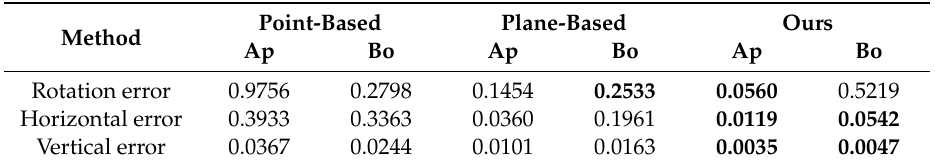
Figure 5. The coarse registration result of Boardroom. ( a ) The source and target point clouds. ( b ) The registration result of the simplified 2D point clouds. ( c ) The registration result of the 3D point clouds. ( d ) The registered point clouds after removing the points on the ceiling for a better view. Table 1. The registration accuracy of the three methods on the indoor dataset. The best results are denoted in bold